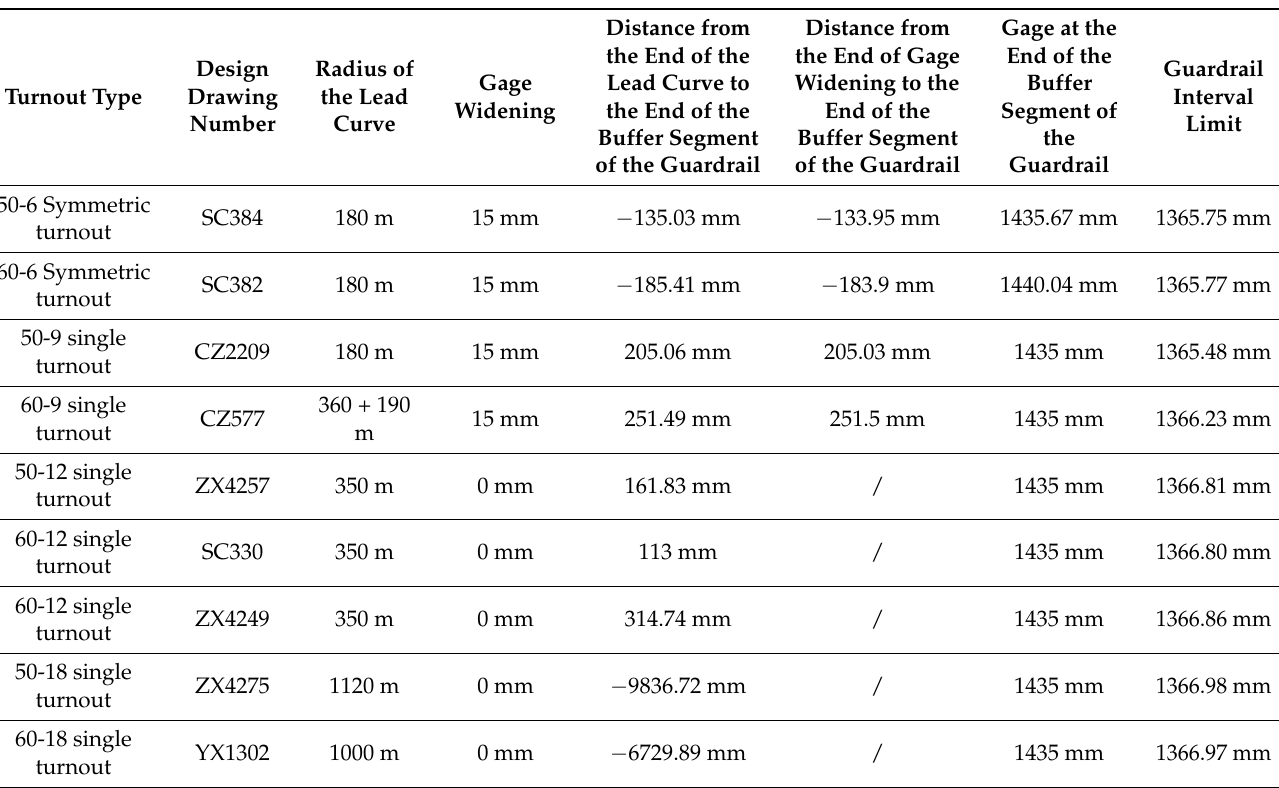
Table 1. Alignment parameters and guardrail interval limits of the main single-turnout